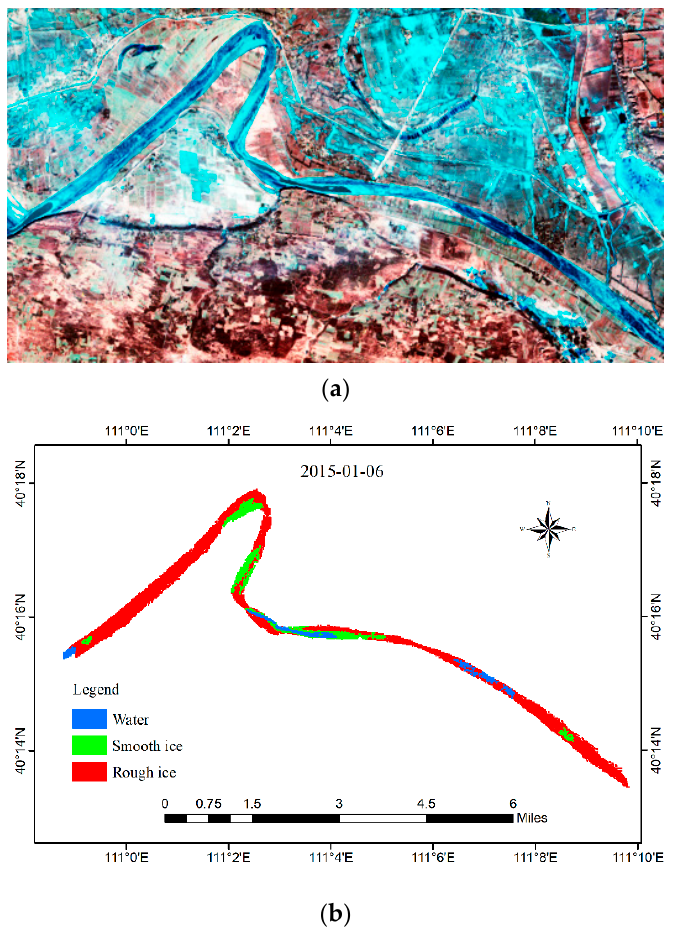
Figure 2. The comparison of the original satellite image ( a ) and the interpreted image of the Shensifenzi bend ( b ).